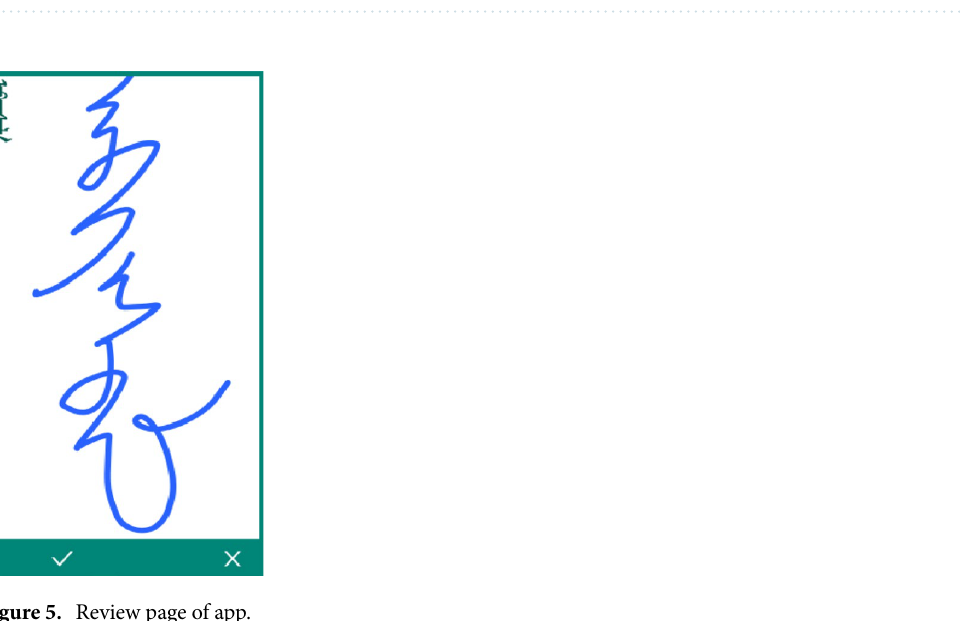
Figure 4. Main page of app.